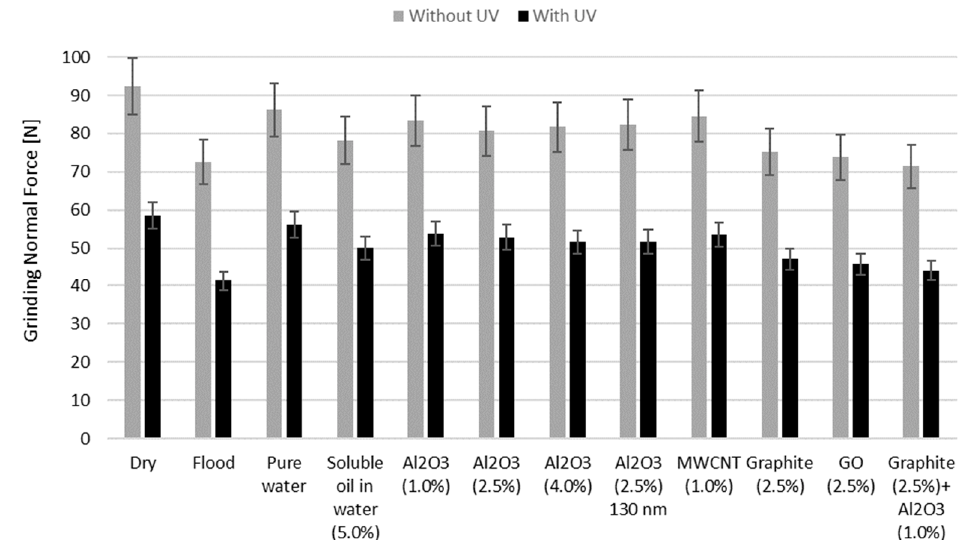
Figure 5. Effect of the presence of UV in minimum quantity lubrication (MQL) grinding on the normal force.